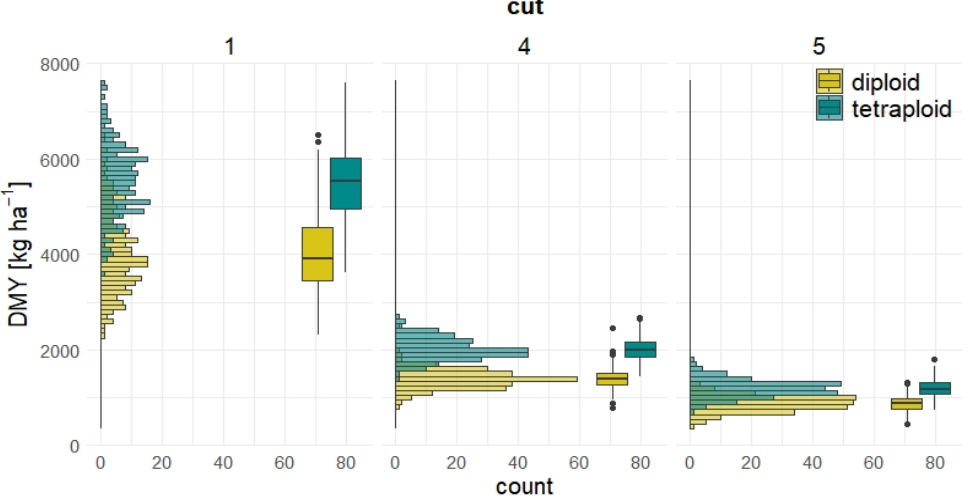
Figure 3. Histogram plots and box plots for the dry matter yield [kg ha − 1 ] estimates across three